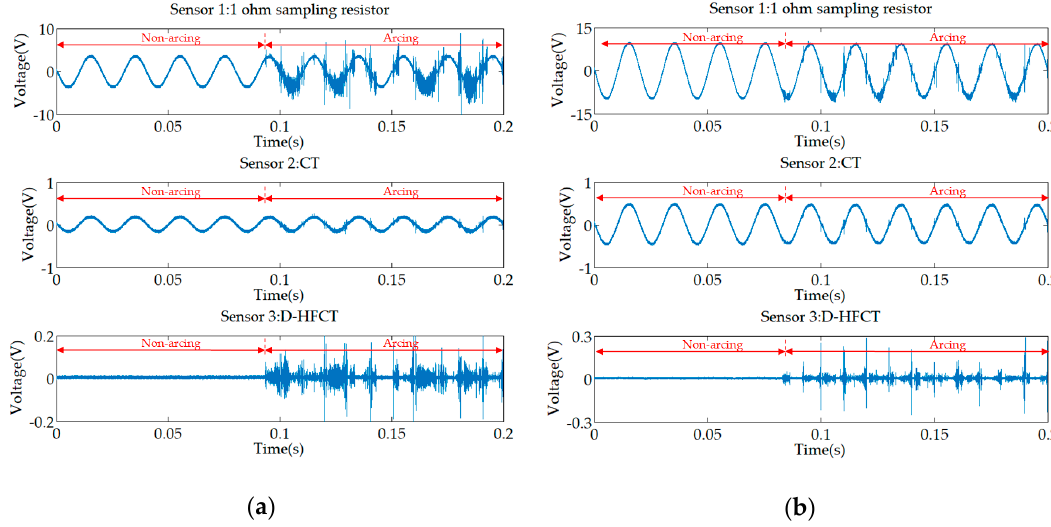
Figure 21. Experimental waveforms of resistive loads. ( a ) Incandescent lamp; ( b ) electric kettle.